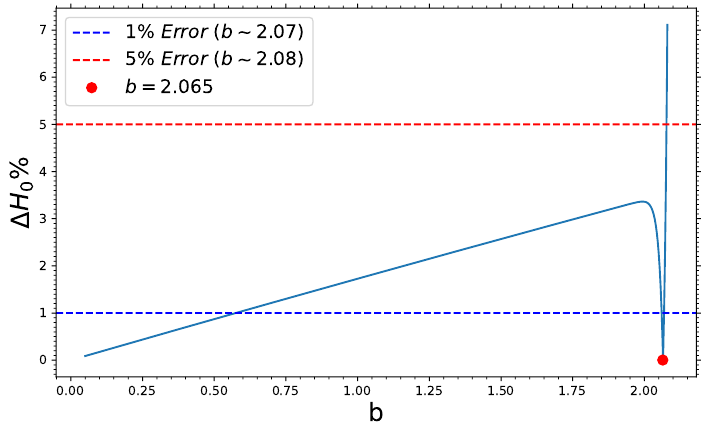
Figure 4. Residual plot of ∆ H 0 computed from the difference of 67.5 km/s/Mpc and H 0 computed at z = 0, w DE ,0 = − 0.95 from Equation (17) for a family of ‘ b ’ values. As seen, the red dot corresponding to b (cid:39) 2.07 marks the point of the lowest residual. The blue and the red dashed horizontal lines mark the 1% and 5% error levels and their corresponding b values.